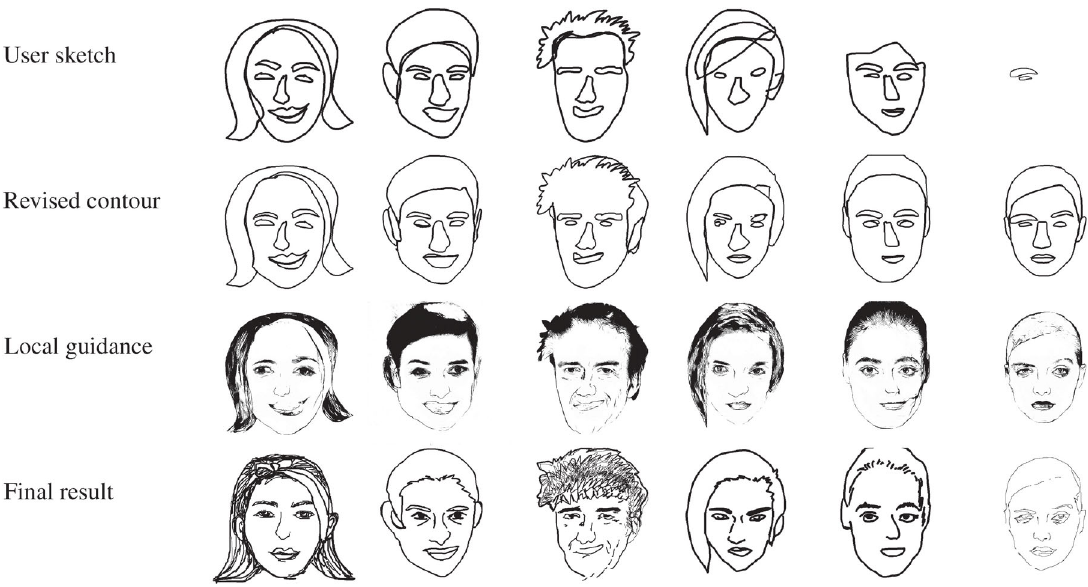
Fig. 6 Some examples of our implementation results. User sketch : results drawn under the global guidance. Revised contour : matched facial masks in local guidance. Local guidance : generated portrait sketch image for user reference. Portrait images in local guidance were selected by users as closest alternatives to user drawing expectations. Final result : final outcome of user drawing.